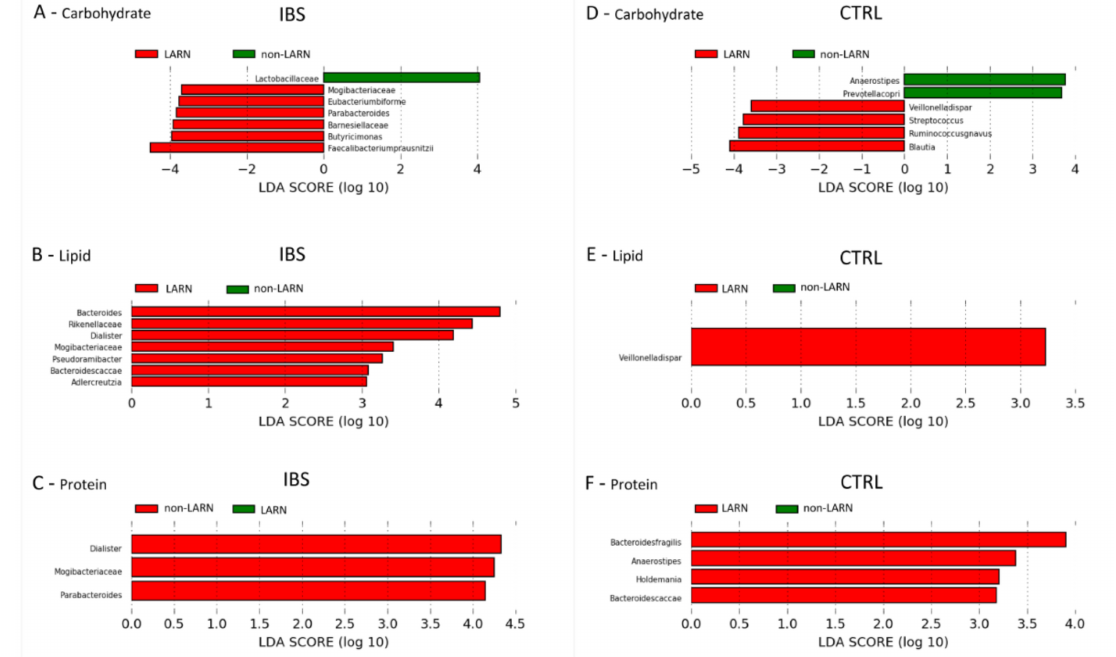
Figure 1. LEfSe analysis of taxonomic biomarkers of gut microbiota in IBS patients and in control subjects. ( A ) IBS samples grouped by carbohydrate intake; ( B ) IBS samples grouped by fat intake; ( C ) IBS samples grouped by protein intake; ( D ) control samples grouped by carbohydrate intake; ( E ) control samples grouped by fat intake; ( F ) control samples grouped by protein